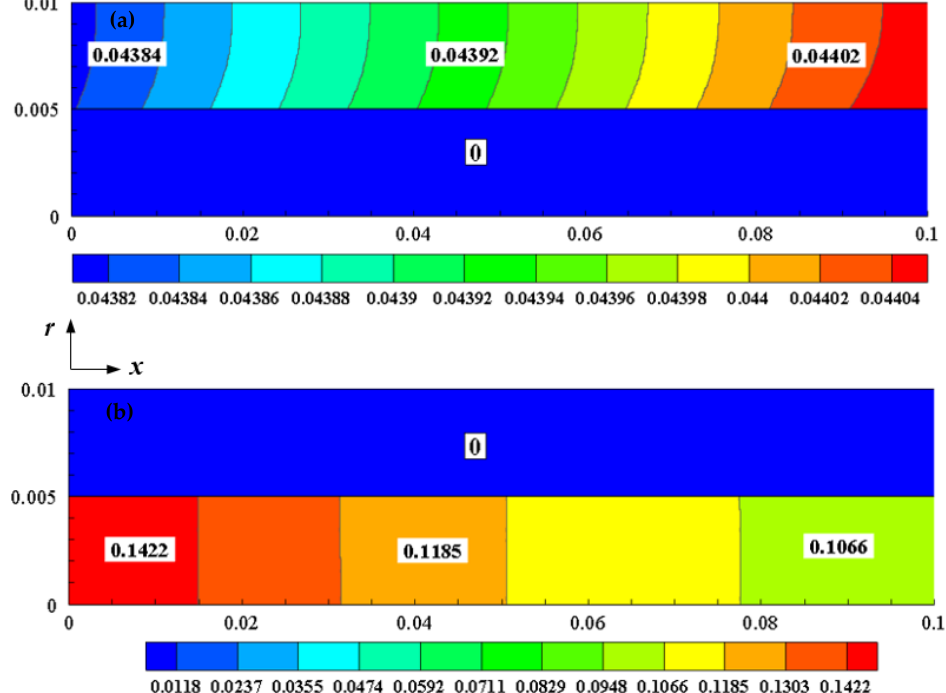
Figure 7. Contours of species concentrations under reactive flow: ( a ) mass fraction of H 2 ; ( b ) mass fraction of CH 4 ; ( x / r = 0.4).